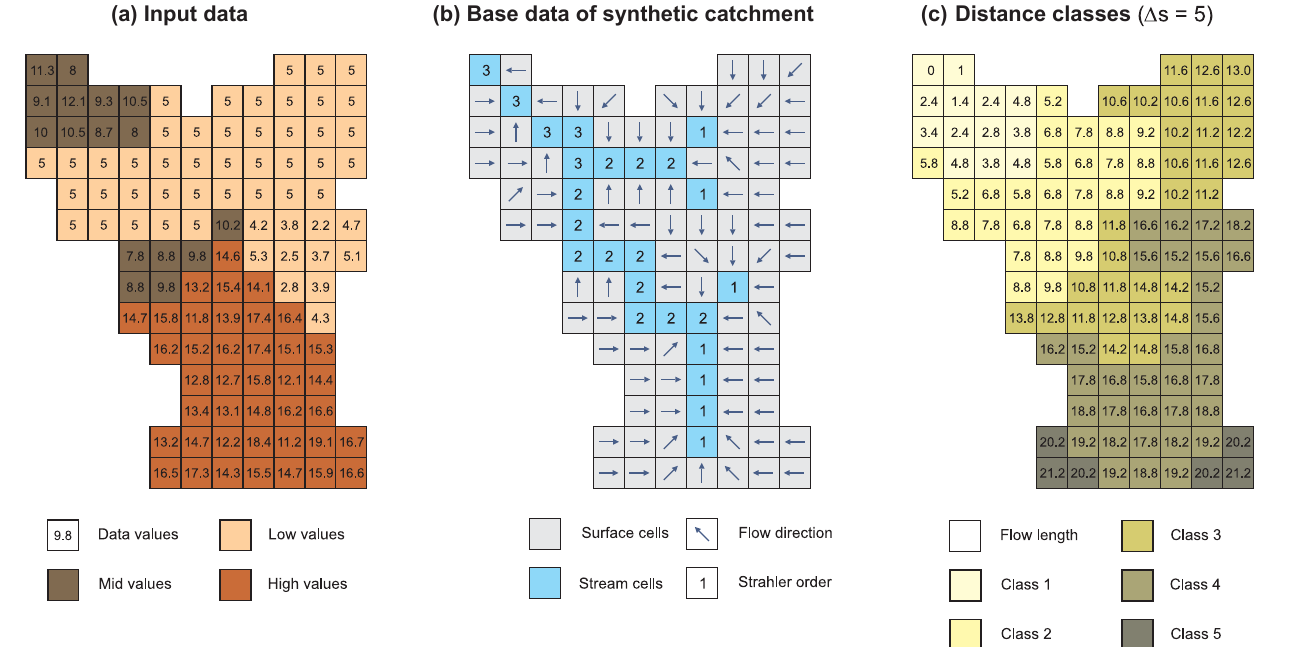
Figure 3. Exemplary input data (a) , flow direction and Strahler order (b) , and distance data and – classes (c) .